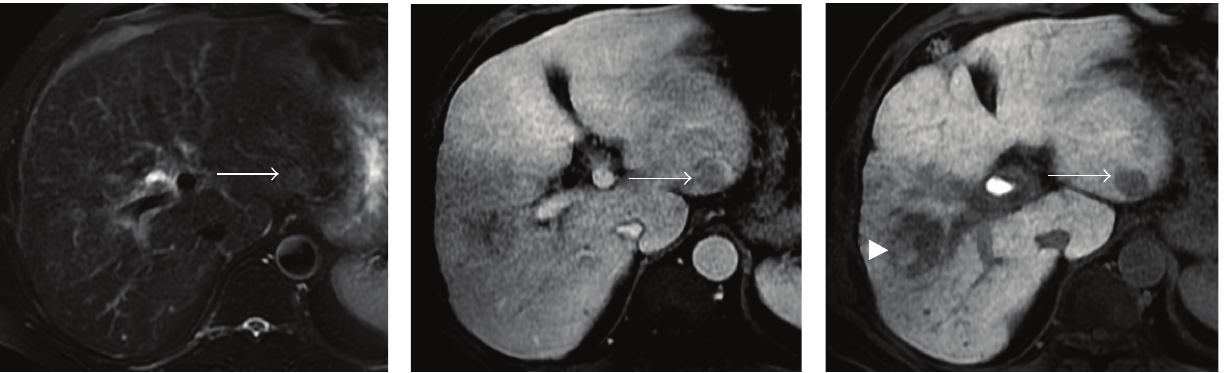
(a) Axial fat-saturated respiratory triggered T2- weighted fast spin echo image (TE 80msec) does not reveal abnormal signal focus in the left lobe, even on retrospective review Figure 3: Chronic HBV patient with known multifocal HCC presumed to be confined to the right lobe, completed one session of TACE. US suggested possible nodule in the left hepatic lobe, but this was occult on multiphasic CT. MRI with standard dose of Gd-EOB-DTPA was